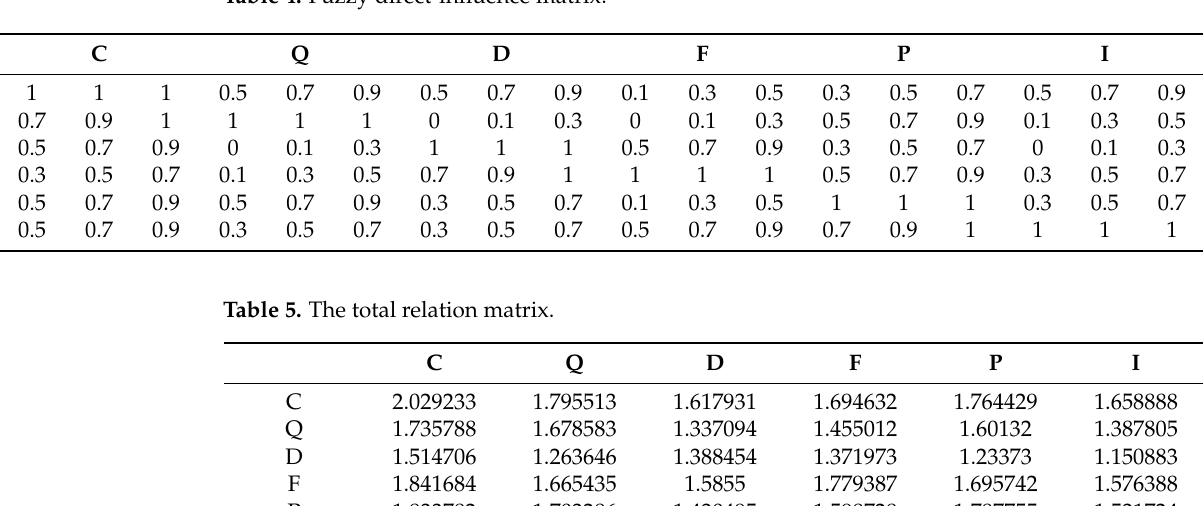
Table 4. Fuzzy direct-in fl uence matrix.